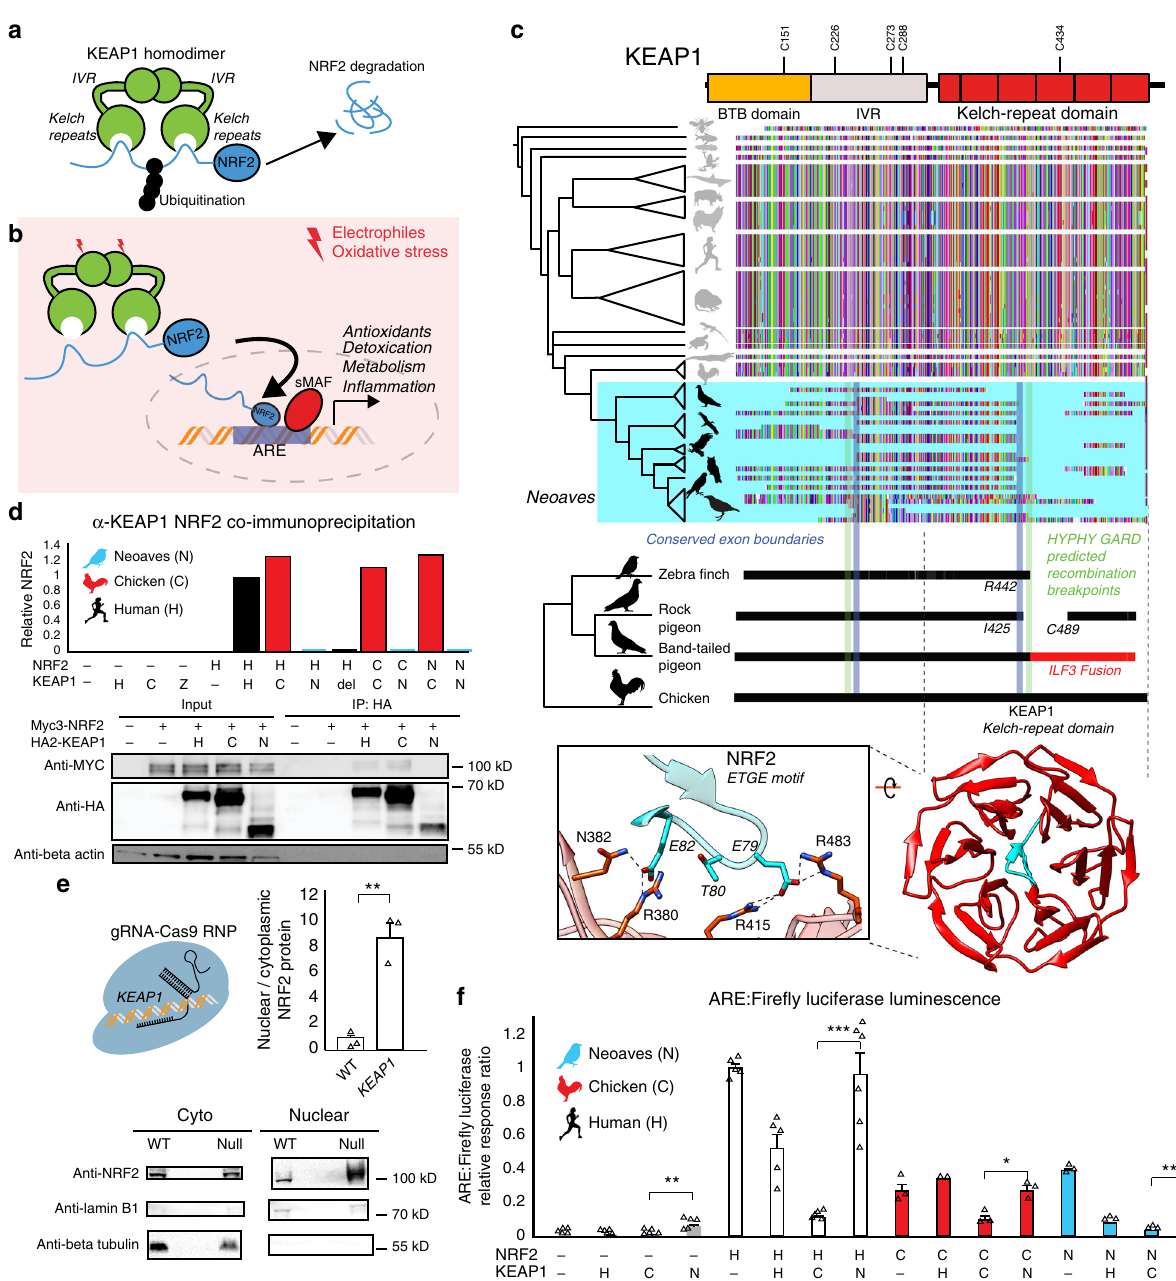
Fig. 1 Comparative genomics reveals a loss of KEAP1-NRF2 binding in Neoaves. a KEAP1-mediated ubiquitination of NRF2 leads to proteasomal degradation 30 . b Under oxidative stress, covalent modi fi cation of KEAP1 cysteine sensors trigger NRF2 release and expression of antioxidant response element (ARE)-regulated genes. c Alignment of translated KEAP1 coding sequences obtained from animal genomes. Only fragments of KEAP1 could be retrieved across Neoaves genomes (Supplementary Data File 1). A C-terminal fragmentation pattern includes fusion with neighboring genes ( ILF3 ) and coincides with statistically predicted genetic recombination breakpoints (HYPHY, GARD; green lines; “ Methods ” ) that overlap KEAP1 exon boundaries (blue lines). This C-terminal fragmentation pattern affects the sequence integrity of the KEAP1 kelch-repeat domain, which is responsible for binding NRF2 (blue, zoom-in; [PDB ID: 2FLU]) 81 . d Co-immunoprecipitation of HA-KEAP1 and MYC-NRF2 constructs from transfected HEK293T cell lysates. Relative NRF2/KEAP1 protein levels normalized to that of Human WT demonstrate that both Δ 442-488 KEAP1 (del) and Neoaves (N) ( Taeniopygia guttata ) KEAP1 are incapable of binding co-transfected Human (H), Chicken (C), and Neoaves (N; Zonotrichia albicollis ) NRF2. e KEAP1 loss of function ( “ null ” ) in Cas9- RNP-treated HEK293T cells leads to increased nuclear NRF2 localization. [ N = 3; one-sided t test, p = 0.0013]. f Loss of NRF2 binding in Neoaves KEAP1 causes increased transcriptional activity of NRF2, as measured by ARE-driven luciferase expression in Cas9-RNP-treated HEK293T cells transfected with various Human and avian KEAP1 and/or NRF2 constructs [ N = 6, except for: = 2 (C/H); = 3 (C/ − ; C/C; C/N, N/ − , N/H, N/C, N/N); = 5 (H/ − , H/H, H/C); all N are biologically independent cells; * p < 0.05; ** p < 0.01; *** p < 0.001. Two-sided t test]. Source data are provided as a Source data fi le. All data are presented as mean values. All error bars represent standard